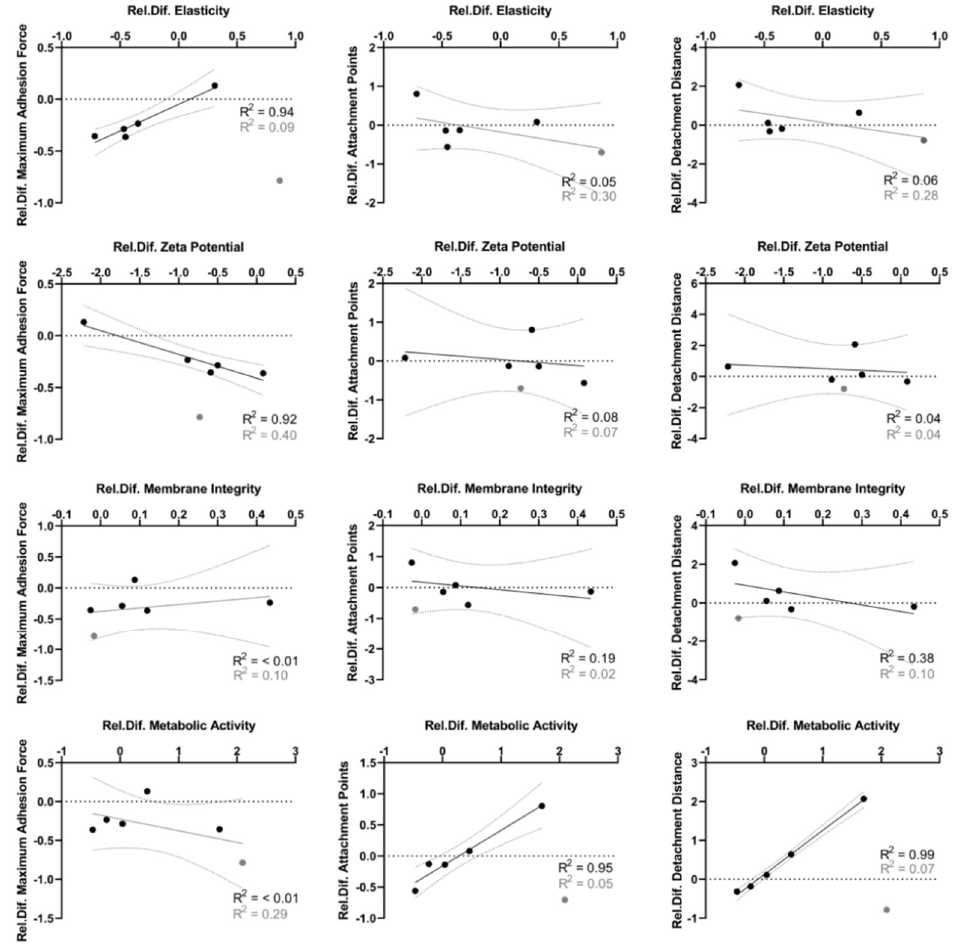
Figure 5. Linear regression analysis between cellular characteristics and adhesion force measurement results across species. Each black dot represents the relative difference of respective absolute values in PBS to RTF buffer for one species. Values for S. oralis are shown as gray dots. Linear regression fit is shown with 95% confidence interval and the corresponding correlation coefficient R2. For black lines and R2, S. oralis was excluded from calculation. Gray lines and R2 also include the gray values of S. oralis .